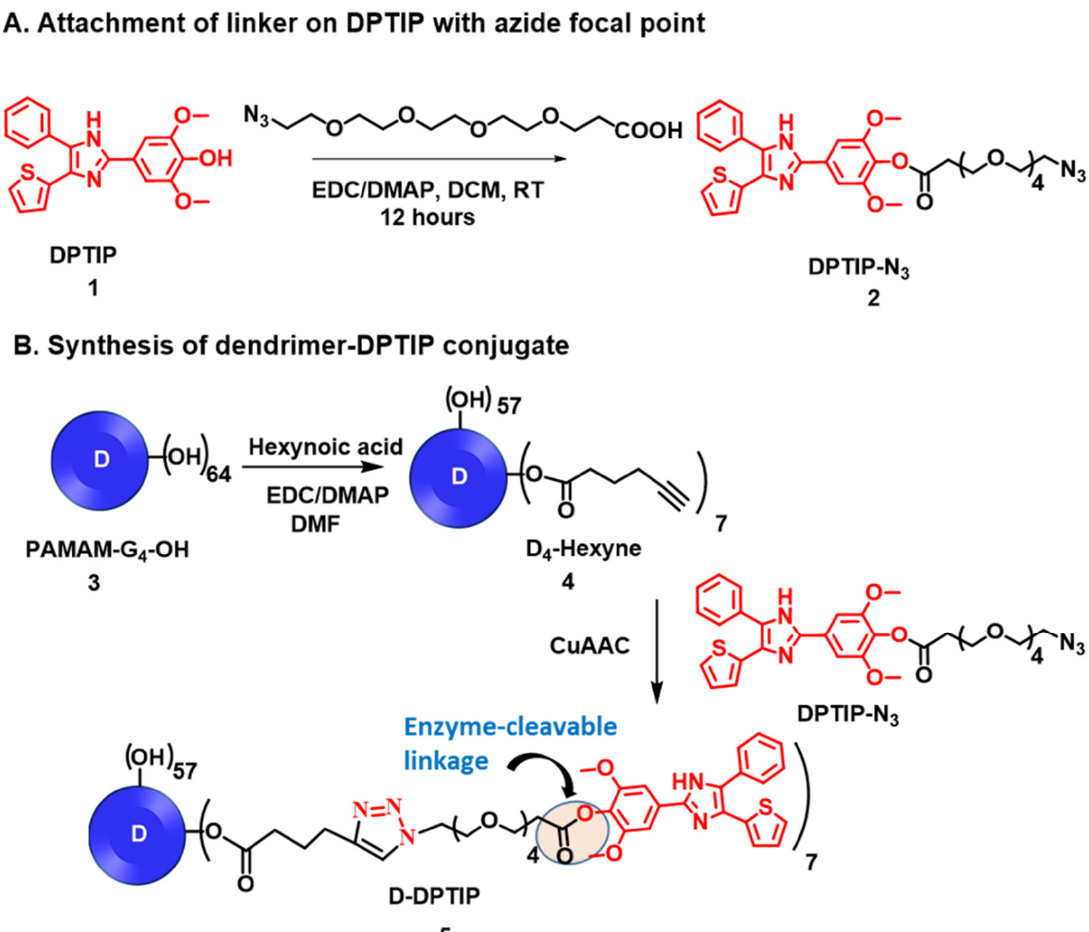
Figure 1. Schematic representation for the synthesis of D-DPTIP conjugate. ( A ) The modification of 2,6-Dimethoxy-4-(5-Phenyl-4-Thiophen-2-yl-1H-Imidazol-2-yl)-Phenol (DPTIP) to obtain a clickable DPTIP-azide; ( B ) synthesis of clickable dendrimer and D-DPTIP conjugate via CuAAC